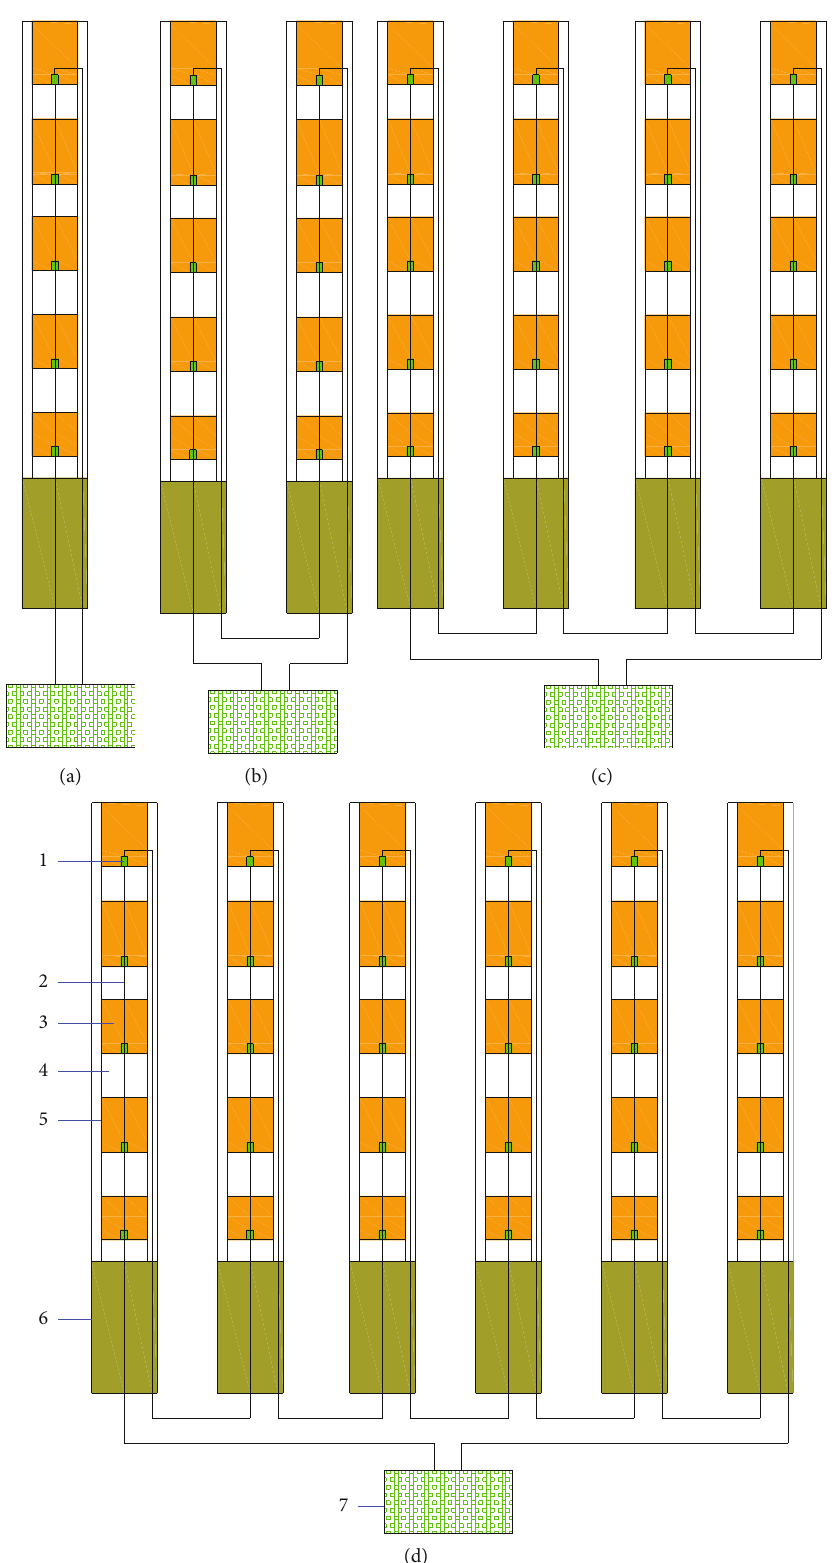
Figure 7: SCB tests: (a) single hole, (b) double holes, (c) four holes, and (d) six holes (1: detonator; 2: connecting wire; 3: explosive; 4: air; 5: directional slit tube; 6: sealing mud; 7: detonating